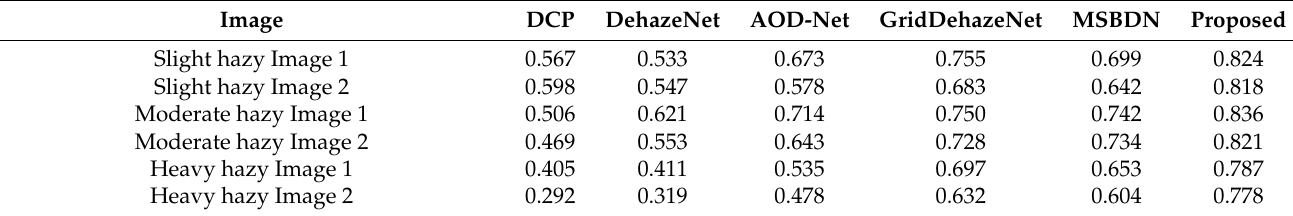
Table 6. Experimental results on different images: SSIM.